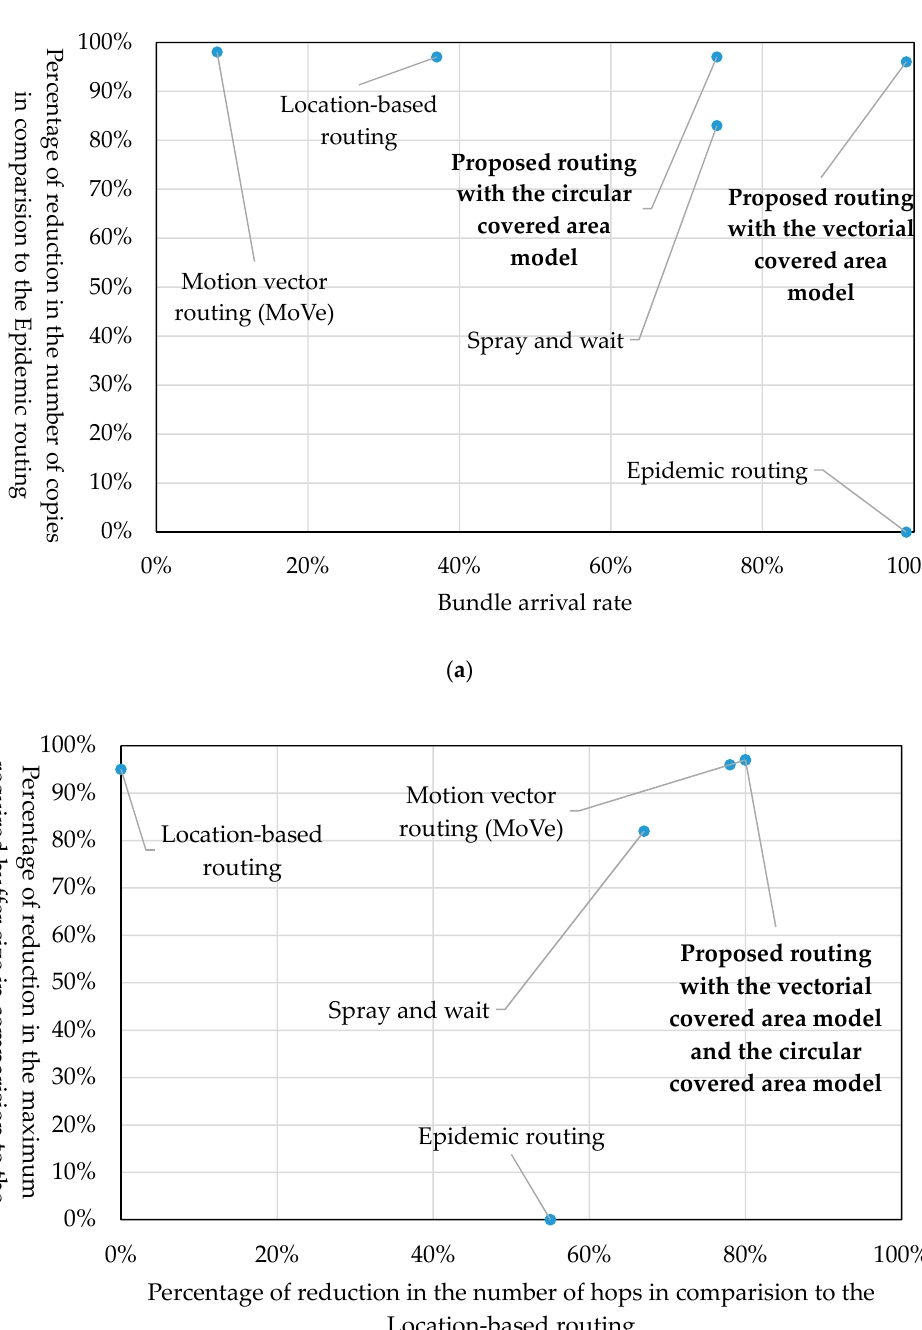
Figure 29. Characteristics of the proposed and other methods selected for comparison. ( a ) Percentage of reduction in the bundle arrival rate and the numbers of copies; ( b ) percentages of reduction in the number of hops and the maximum required buffer